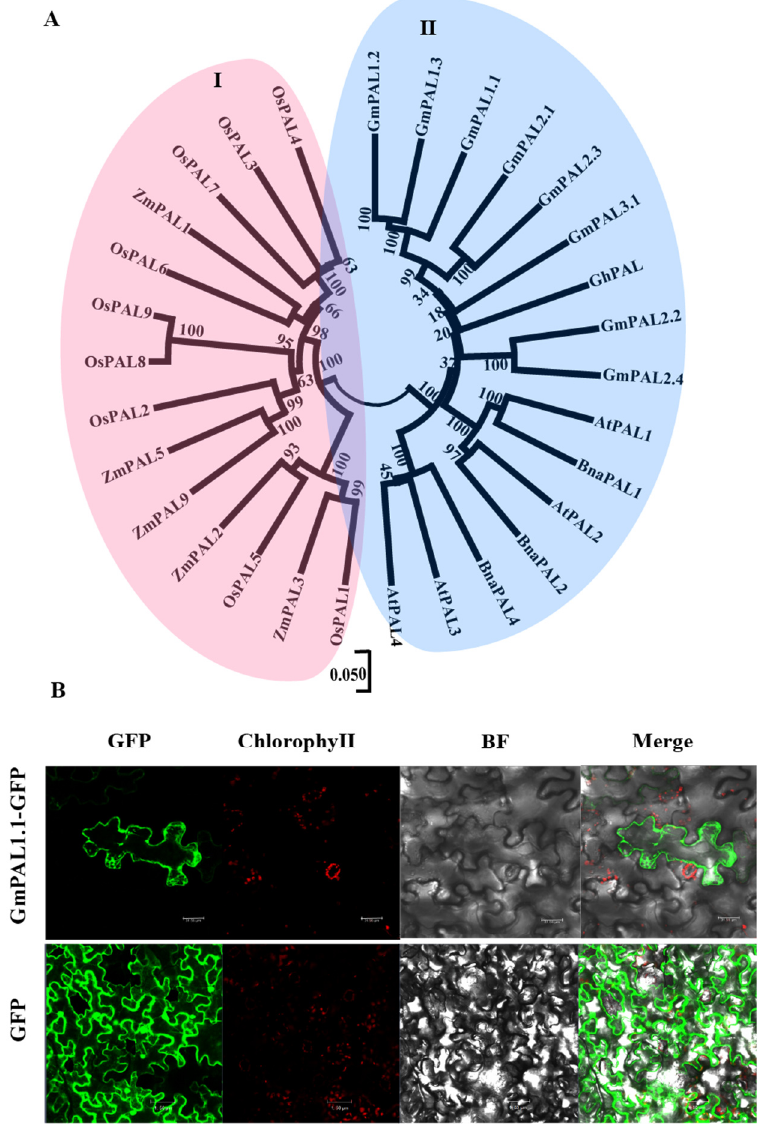
Figure 1. Sequence analysis and subcellular localization. ( A ) Phylogenetic analysis of PALs from soybean and other crops. Phylogenetic tree was constructed by neighbor-joining method using MEGA-X software. The amino acid sequences of PALs were all obtained from the NCBI database. Gm, Glycine max ; At, Arabidopsis thaliana ; Bna, Brassica napus ; Os, Oryza sativa ; Zm, Zea mays . ( B ) Subcellular localization of GmPAL1.1 in tobacco. The coding sequence of GmPAL1.1 without stop codon was constructed into pBinGFP4-GFP vector and transformed into four-week-old tobacco leaves using Agrobacterium -mediated transformation. The injected area was observed using laser confocal microscope. GFP, empty carrier protein; GmPAL1.1-GFP, fusion protein; BF, brightfield; Chlorophy II, autofluorescence emitted by chloroplasts.